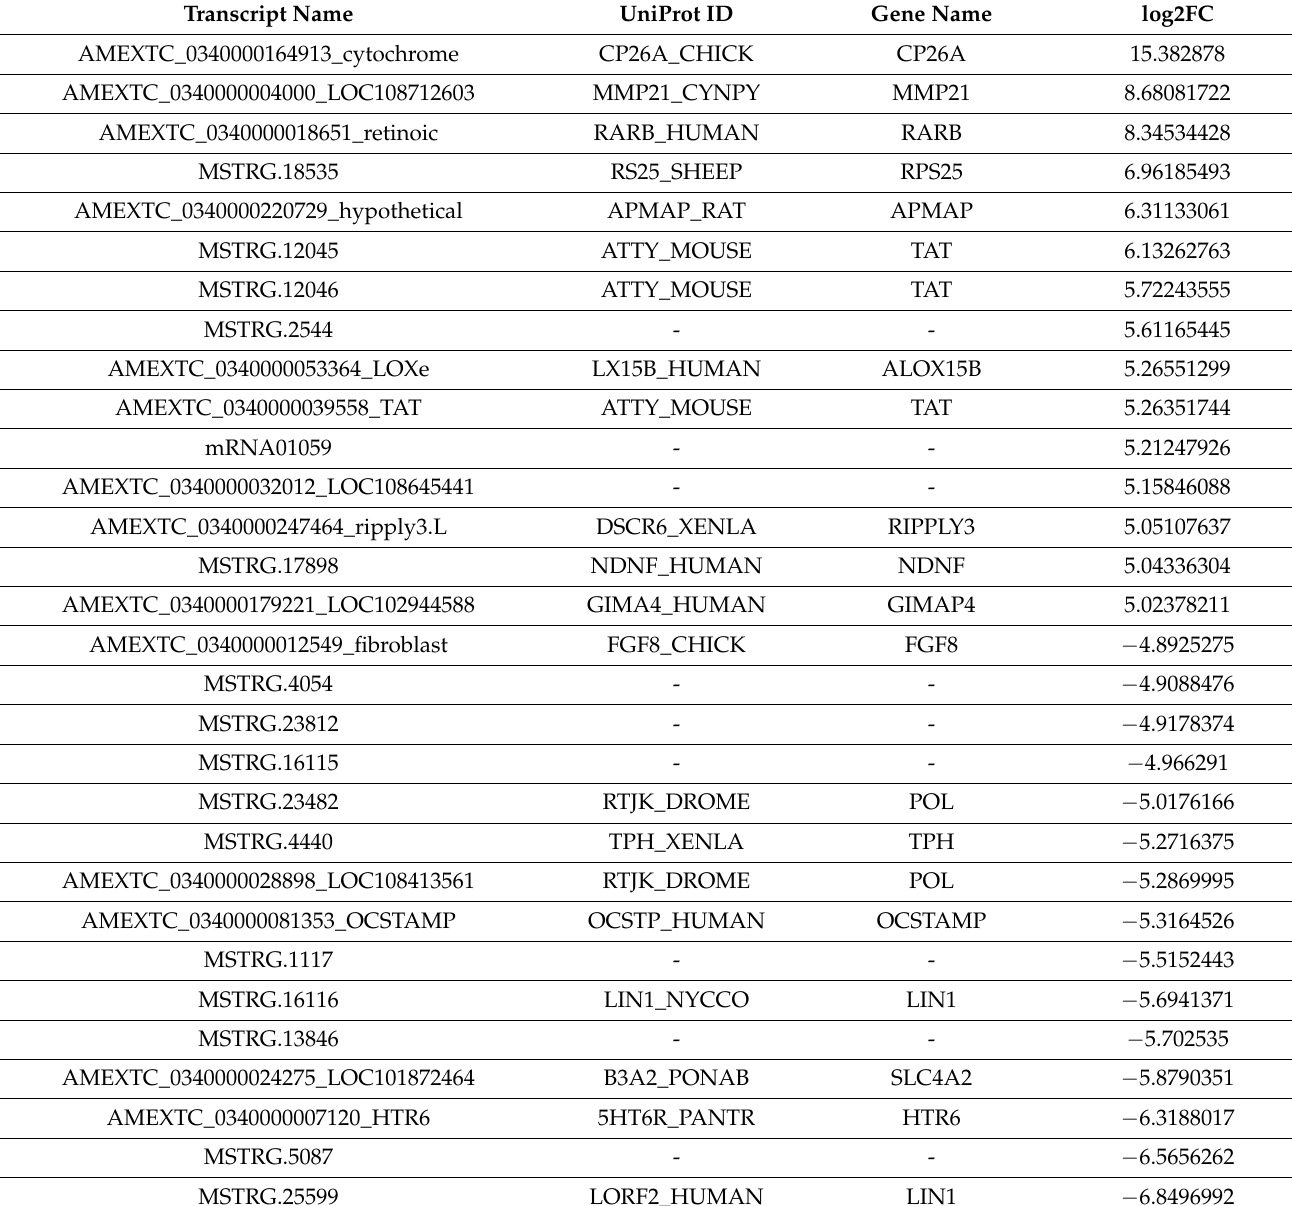
Table 1. Top 30 differentially expressed transcripts. Transcript name is given as “AMEXTC” if found in the reference genome or “MSTRG” if identified as novel by StringTie. UniProt identification and gene names are given for transcripts with a significant BLASTx